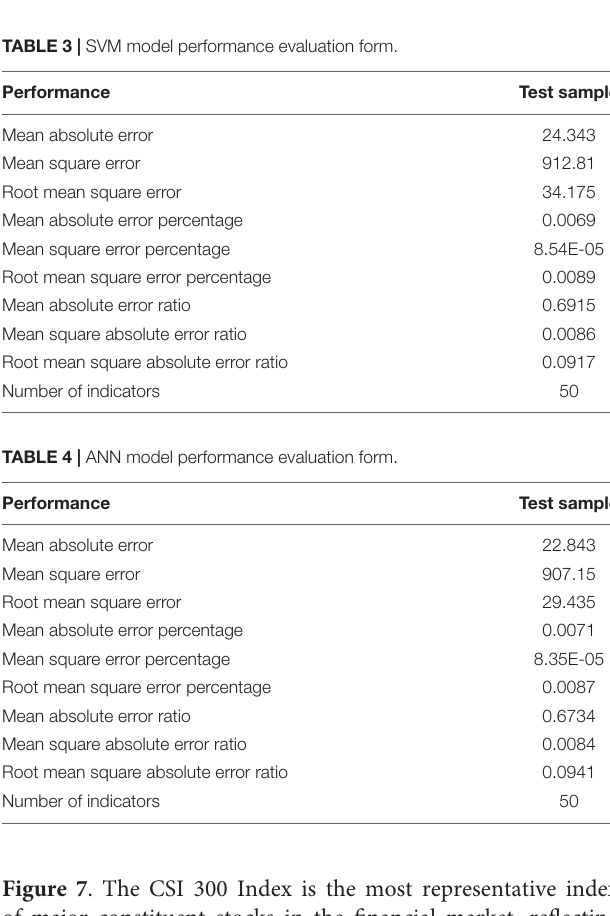
Figure 7 . The CSI 300 Index is the most representative